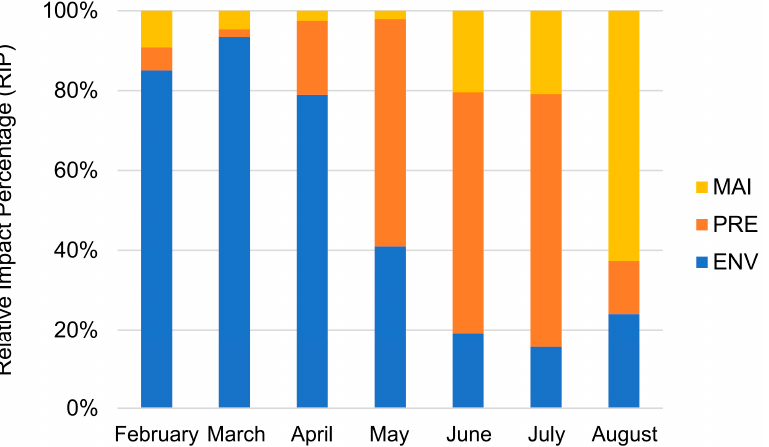
Figure 7. Relative impact percentage (RIP) of three influencing factors on the distribution of the FAW from February to August 2020.